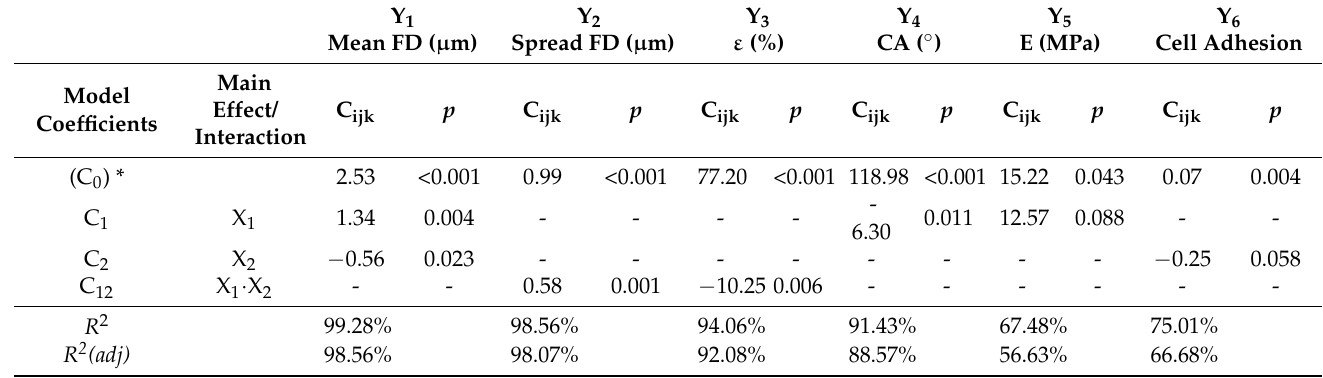
Table 5. Fitted coefficients for the factorial model in Equation (4) fitted in coded units for Y 1–6 along with p -values * per each term and the global R 2 . p -values smaller than 0.001 are displayed as